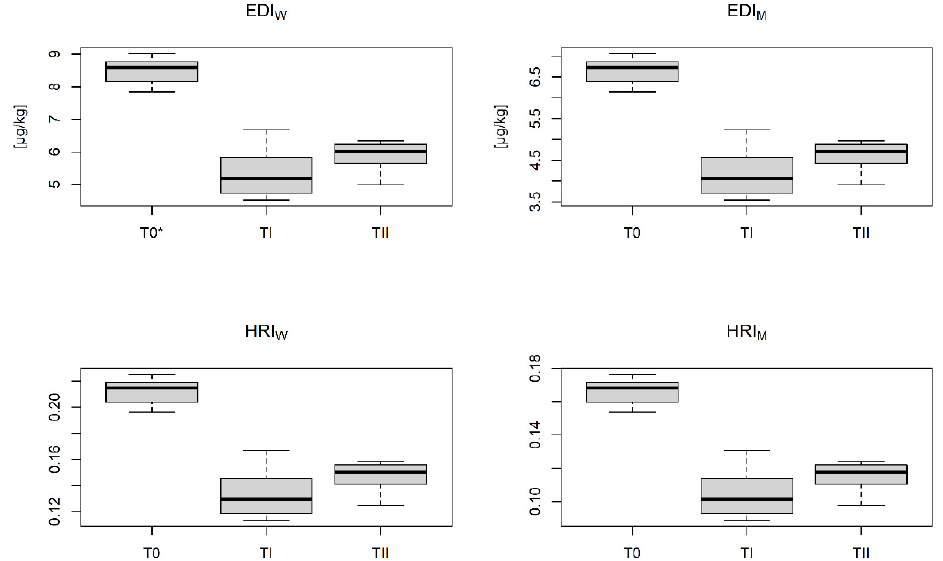
Figure 4. Estimated daily intake (EDI) and health risk index (HRI) calculated for women (W) and men (M) for Cu in camelina; * for descriptions see Material and Methods. Statistically significant differences and p -value are presented in Table 2.